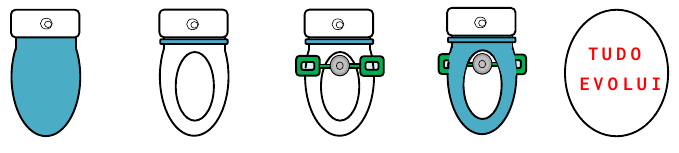
Figura 2. Como instalar o